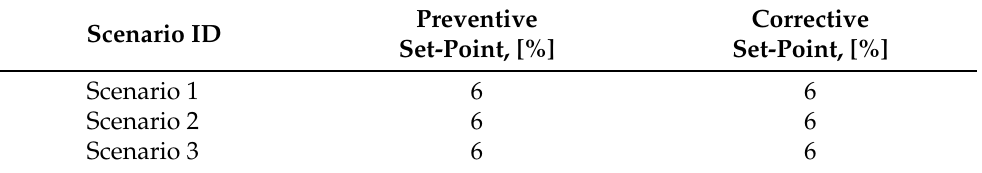
Table 11. Comparison between preventive and corrective set-point plans—12h30 time